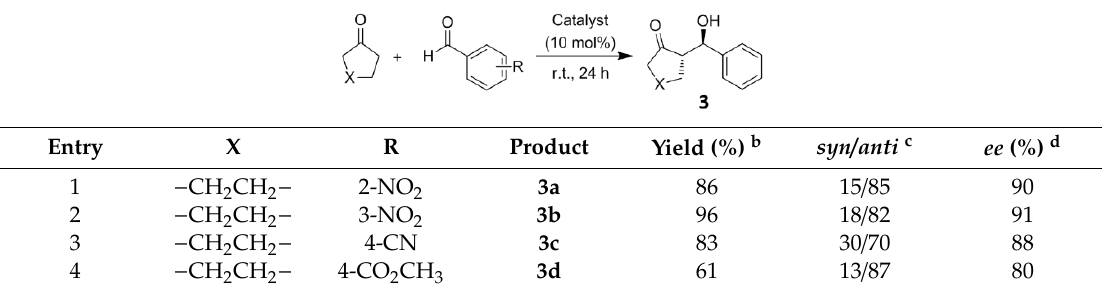
Table 4. Aldol reaction of cyclic ketones with aromatic aldehydes catalyzed by P3 a .